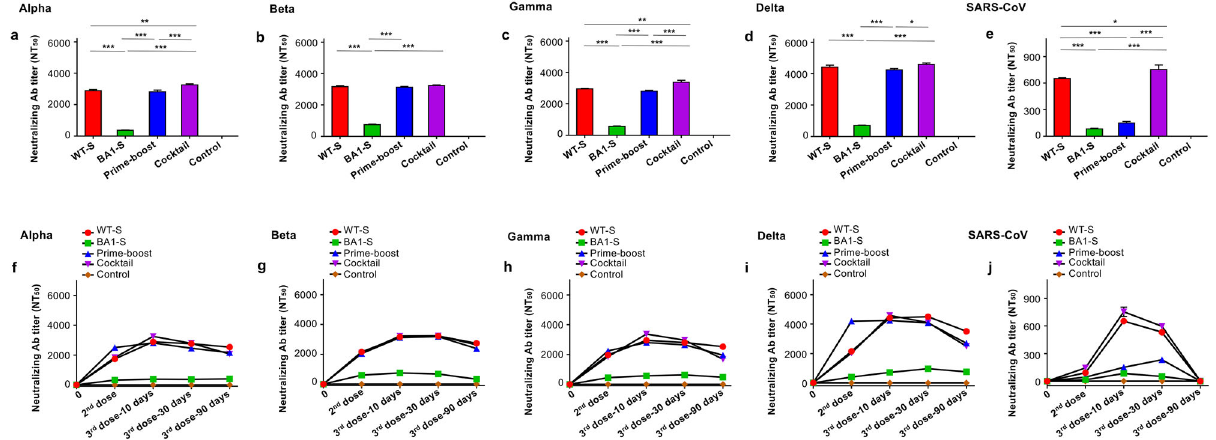
Fig. 3 Cocktail or prime-boost of SARS-CoV-2 WT-S and BA1-S proteins induced potent and durable neutralizing antibodies against other SARS-CoV-2 VOCs and SARS-CoV. BALB/c mouse sera collected 10 days after the second immunization and, 10, 30, and 90 days, respectively, after the third immunization of WT-S, BA1-S, WT-S prime and BA1-S boost, WT-S and BA1-S cocktail, or PBS control were evaluated for neutralizing antibodies against pseudotyped viruses encoding S protein of SARS-CoV-2 Alpha variant containing 10 amino acid mutations (69 – 70 deletions, 145 deletion, N501Y, A570D, D614G, P681H, T716I, S982A, and D1118H) in the S protein, Beta/Gamma variants containing K417N/T, E484K, and N501Y mutations in the RBD, and Delta variant containing L452R, T478K, and P681R mutations in the S1 subunit, as well as the original SARS-CoV. NT 50 was expressed as 50% neutralizing antibody titers against pseudovirus infection in hACE2/293T cells. NT 50 against pseudotyped SARS-CoV-2 Alpha ( a ), Beta ( b ), Gamma ( c ), Delta ( d ) variants, and SARS-CoV ( e ) 10 days after the third immunization, as well as against pseudotyped SARS-CoV-2 Alpha ( f ), Beta ( g ), Gamma ( h ), Delta ( i ) variants, and SARS-CoV ( j ) 10 days after the second immunization and 10, 30, and 90 days, respectively, after the third immunization. The data are expressed as mean ± s.e.m of quadruple wells from pooled sera of fi ve mice in each group. Statistical signi fi cance among different vaccination groups was analyzed using Ordinary one-way ANOVA, and * ( P < 0.05), ** ( P < 0.01), and *** ( P < 0.001) indicate signi fi cant differences. The experiments were repeated twice, leading to similar results.